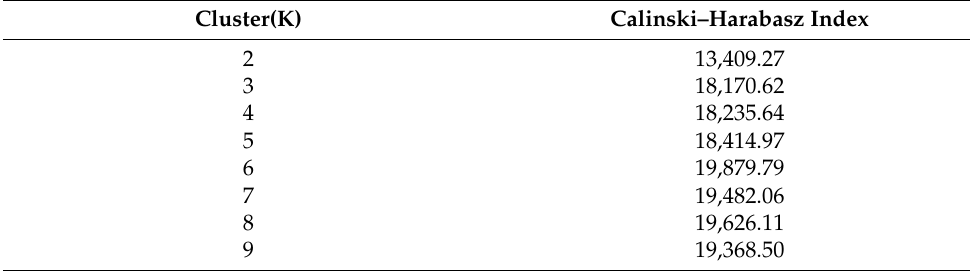
Figure 10. Agglomerative clustering dendrogram using Ward linkage. Table 1. Calinski–Harabasz Index of agglomerative clustering. Table 1. Calinski–Harabasz Index of agglomerative